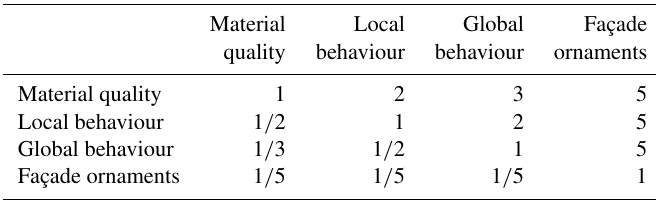
Table A1. Judgement matrix adopted for the calibration of the macro-category weights.